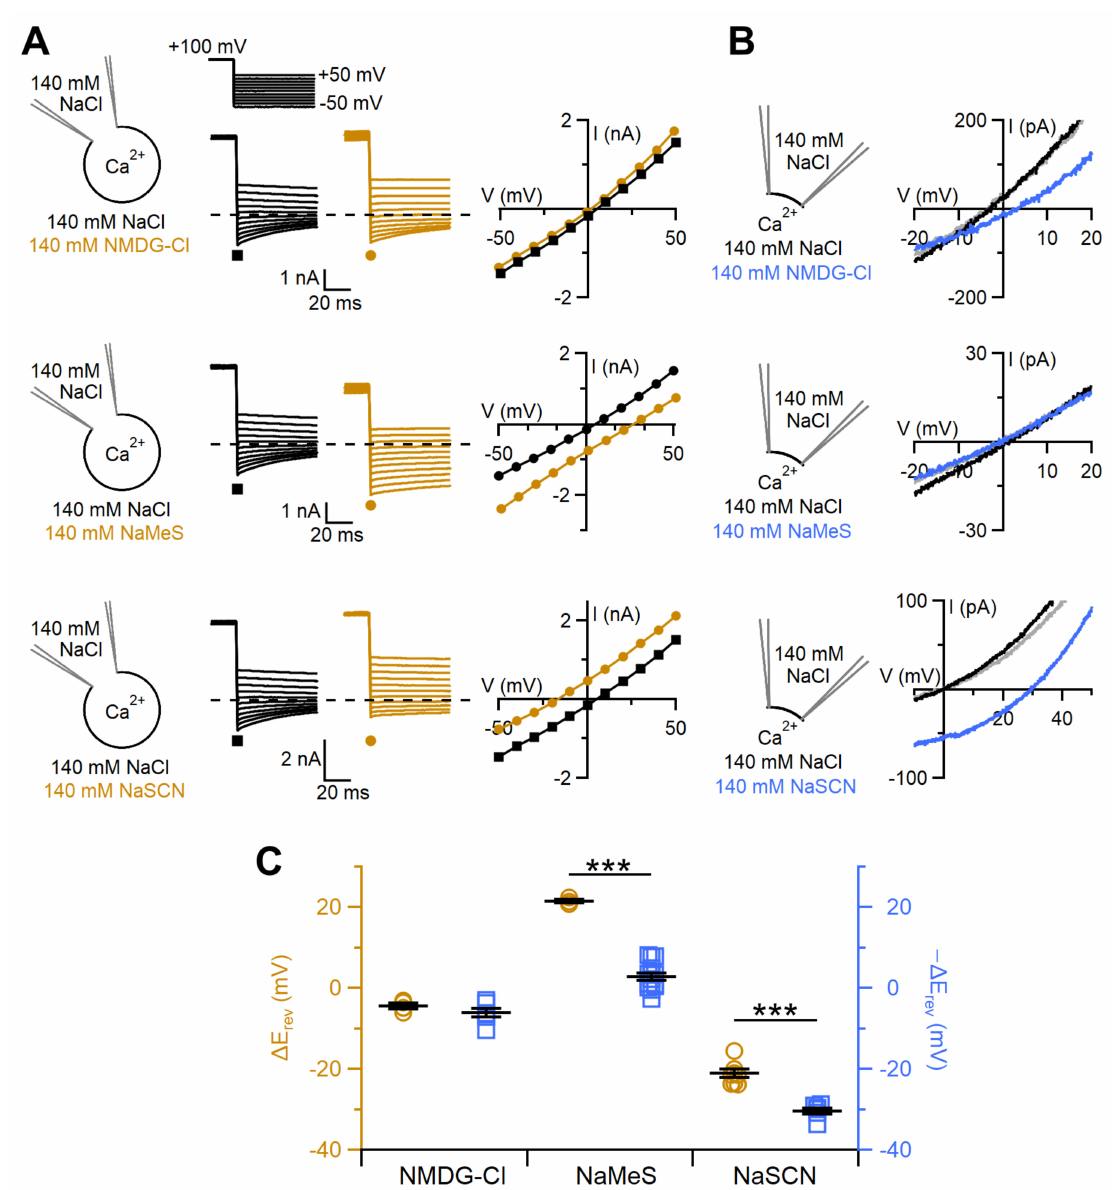
Figure 5. TMEM16F wt ion permeability depends on the recording configuration. ( A ) Representative whole-cell voltage- clamp recordings obtained from TMEM16F wt-transfected cells with intracellular solution containing 100 µ M CaCl 2 . Each cell was exposed to a control solution containing 140 mM NaCl (black traces) or other salts as indicated (brown traces).